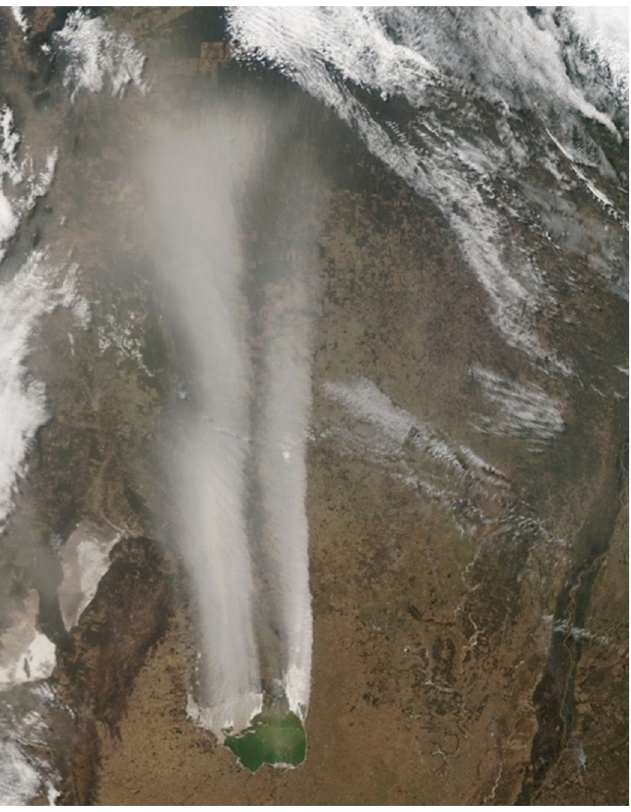
Fig 6. MODIS image of an exceptionally strong salt dust event generated in Mar Chiquita. Date: September 10, 2013. Distance reached by the visible plume: about 800 km. Modis Image: AERONET Cordoba-CETT (aqua), 250 m pixel size, full